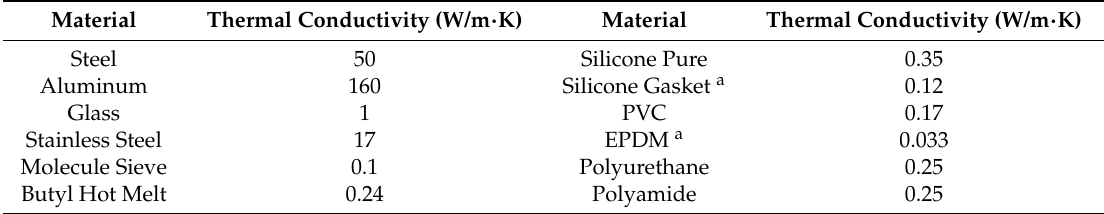
Table 4. Comparison of measured and calculated thermal transmittances of test specimens.